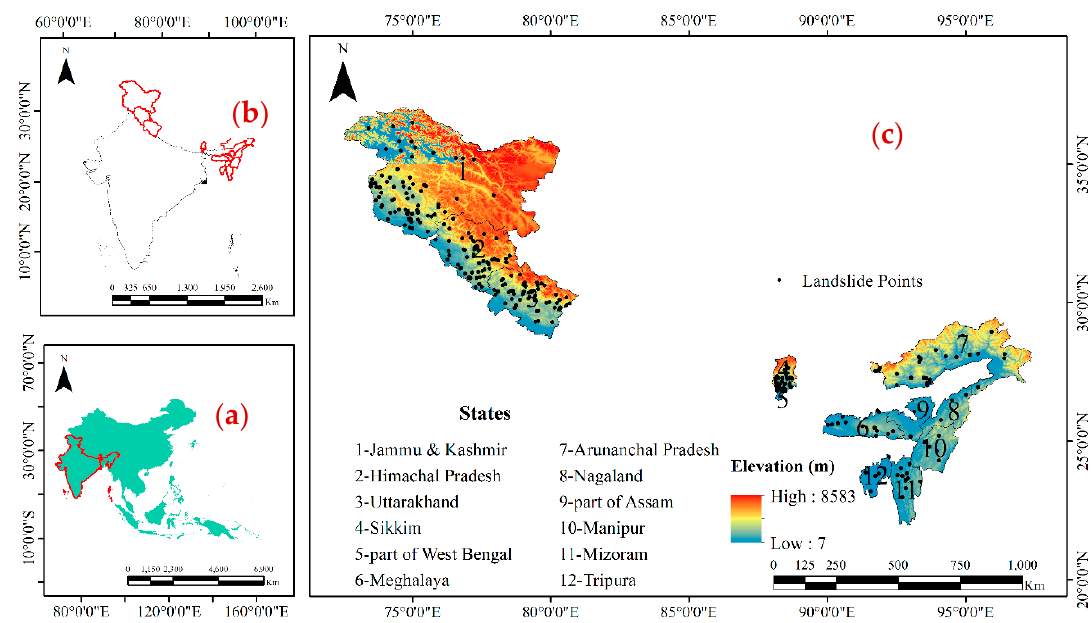
Figure 1. ( a ) Southeast Asia highlighting India; ( b ) geographical boundaries of India highlighting the Indian Himalayan region; and ( c ) location of rainfall-induced landslides in the Indian Himalayan region [1] (DEM Source: SRTM, resolution 30 m).